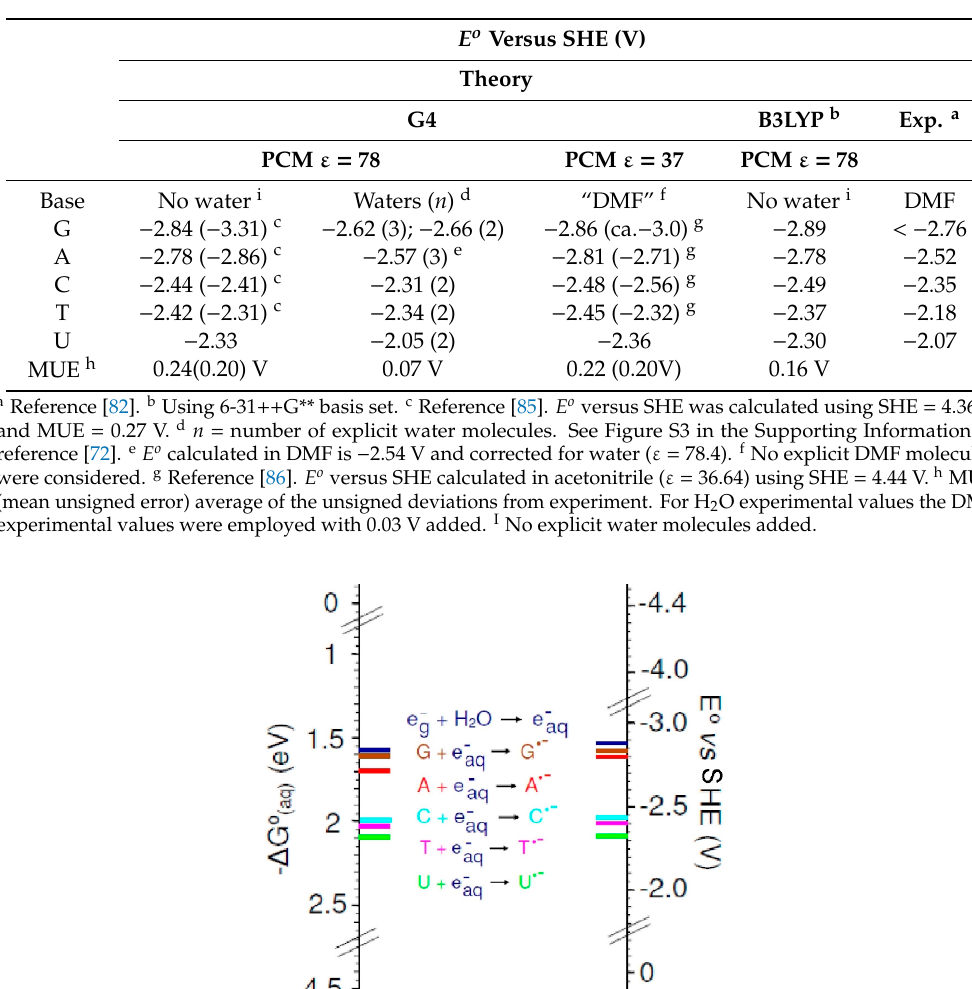
Table 2. E o values of G, A, C, T, and U in Water and in DMF Calculated Using G4 Theory and B3LYP Methods along with the Experimental E o Values in DMF.